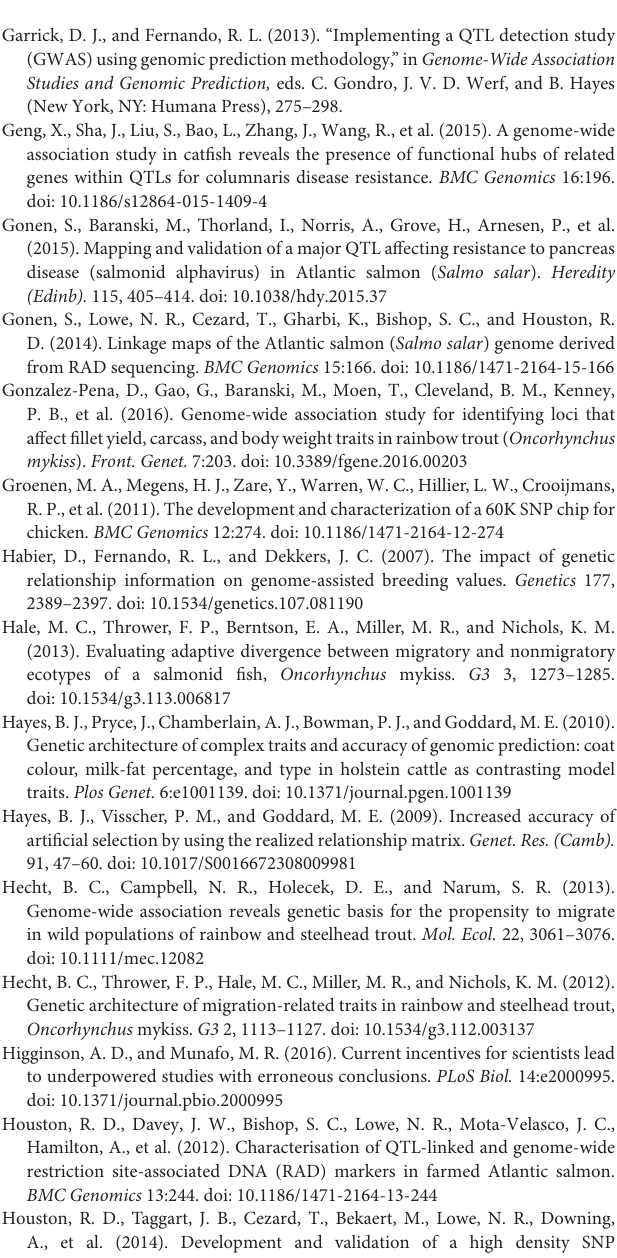
Figure S1 | Manhattan plot showing the association between SNP genomic windows and BCWD resistance in TLUM sample genotyped with 57K Chip-SNP: